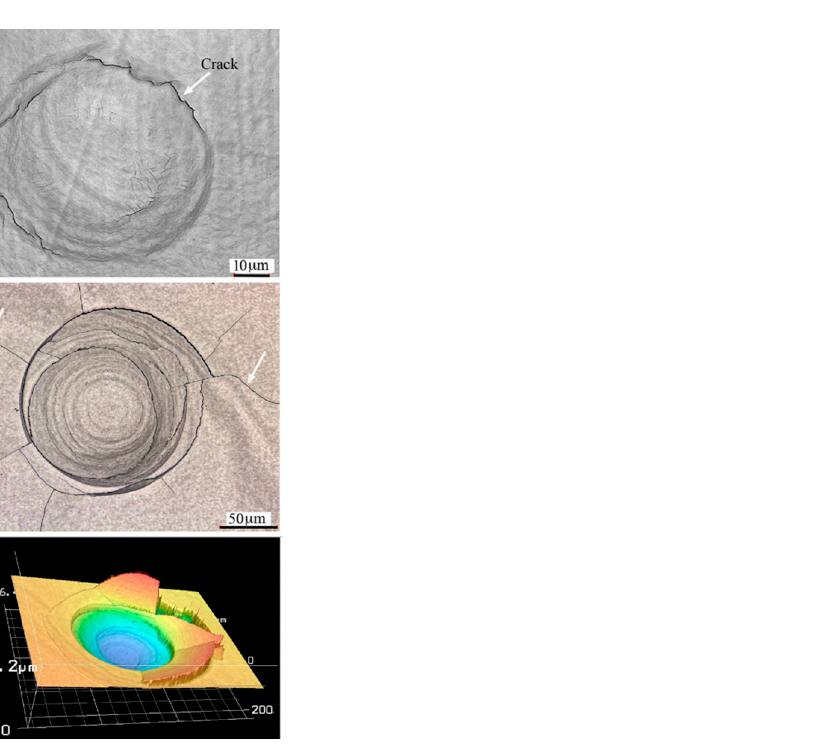
Figure 28. Laser-optical micrograph of the PT coating at 350 °C showing crack formation under a ball indentation after different applied loads: ( a ) 6 N, ( b ) 20 N; and ( c ) 3-dimensional profile after loading 20 N [218]. (Reproduced with permission from refs. [218] . Copyright (2015 ), Else- vier).